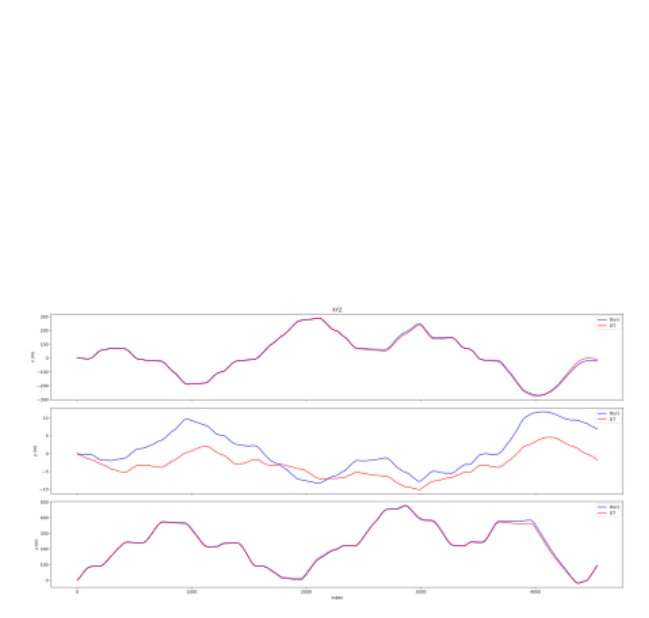
Figure 7. The drift on the different